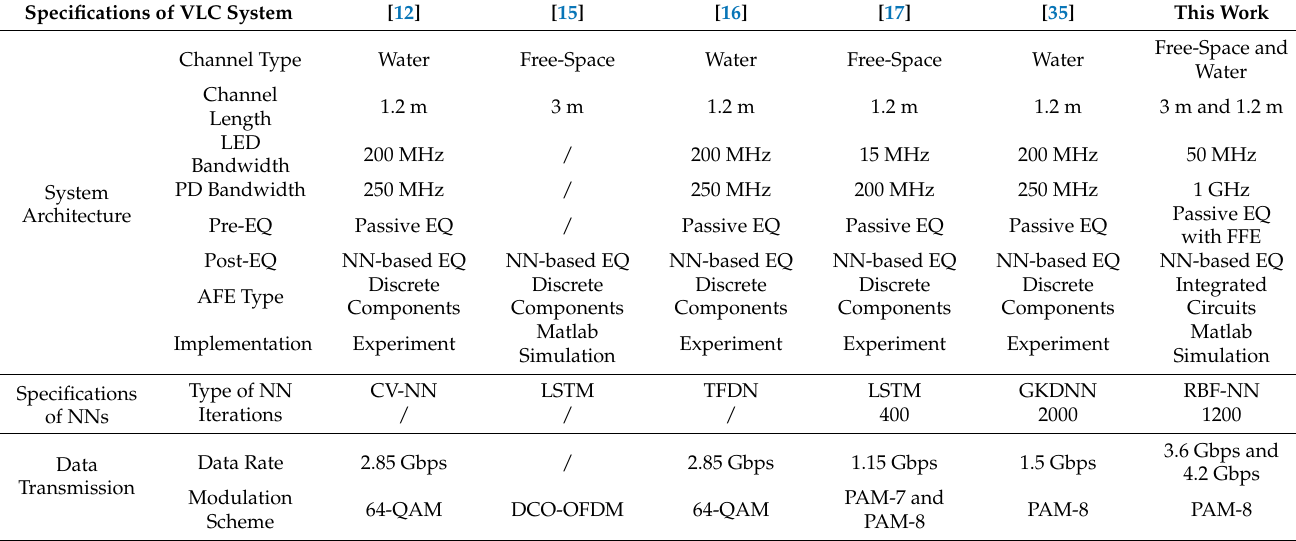
Table 3. Comparison of neural-network-enabled VLC systems.